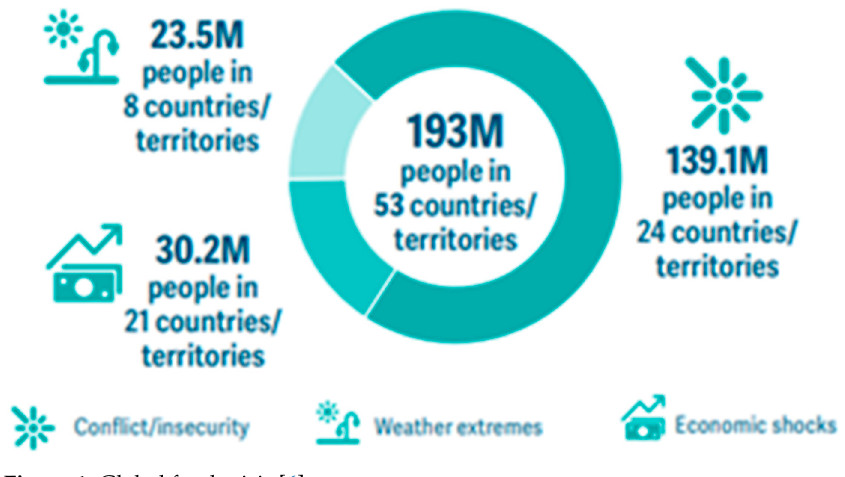
Figure 1. Global food crisis [6].